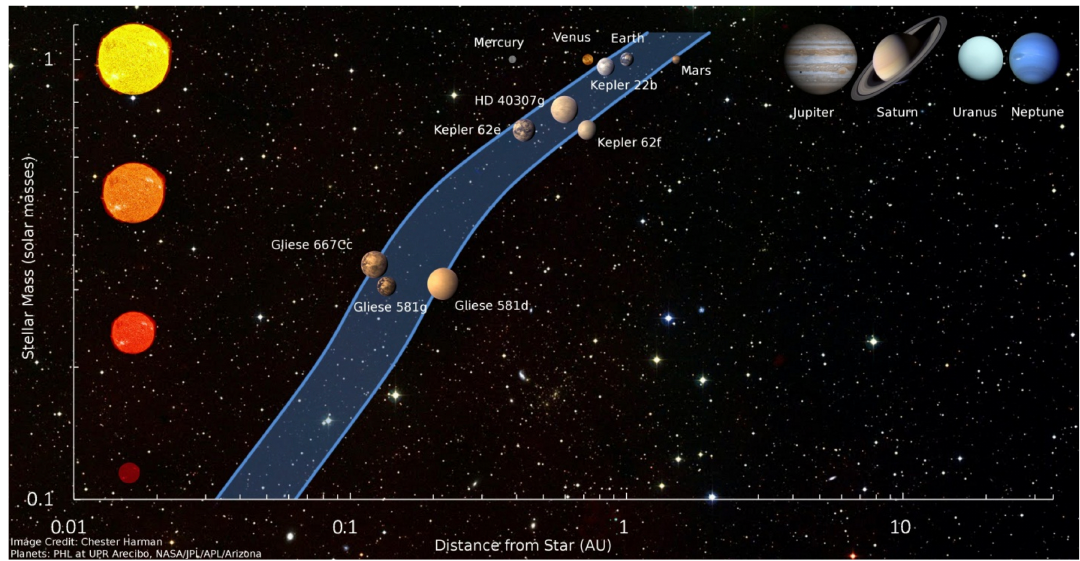
Figure 12. Figure showing how the habitable zone varies with star mass. Stars with masses less than that of the Sun are less luminous and cooler, and hence, the habitable zone moves closer to the star as the star mass decreases. (Figure from